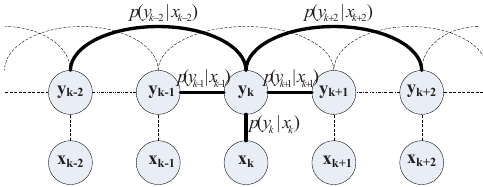
Figure 3: Belief propagation in our scenario. The solid lines show the messages received by node k from neighbouring four (cid:2) T t =1 α t h t ( x ) (cid:2) . P ( y i | x i ) T t =1 α t